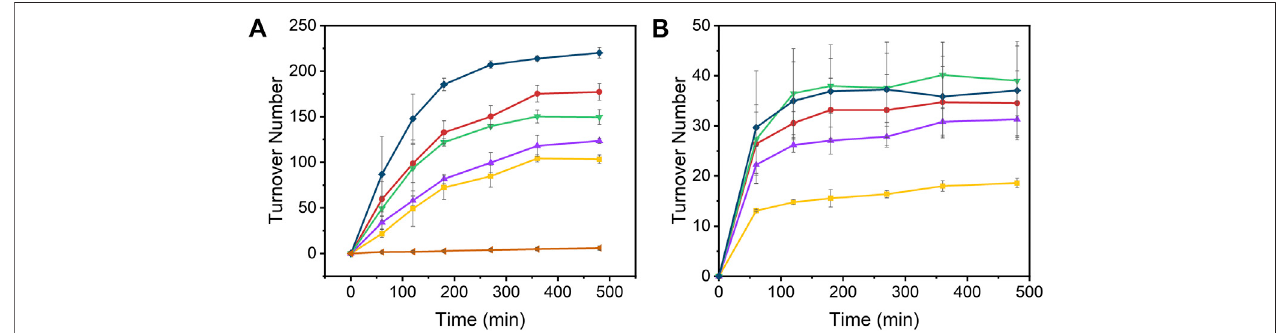
FIGURE2| Turnovernumbervaluesof (A) H 2 and (B) COovertimefromthephotoinducedreductionofprotonsby[Ru(bpy) 3 ] 2+ ,CoPPIX,andCo-cyt b 562 mutants at pH 6.0 under 1 atm CO 2 . The experiments were carried out in 100 mM ascorbic acid, 1 mM [Ru(bpy) 3 ] 2+ , 200 mM potassium phosphate, 20 µM CoPPIX (except in the negative control), and 30 µM of corresponding apo cyt b 562 (except for free CoPPIX; apo WT cyt b 562 was used for the negative control) under white LED light irradiation. Colors represent [Ru(bpy) 3 ] 2+ (negative control, orange side triangles), free CoPPIX (yellow squares), WT (red circles), M7A (purple up triangles), M7H (greendowntriangles),andH102A(darkbluediamonds).TheTONforthenegativecontrolwascalculatedassumingahypotheticalcatalystcontentidenticaltotheother samples (8 nmol) for direct comparison. The experiments were run on triplicate and error bars represent the standard deviation of the sample.